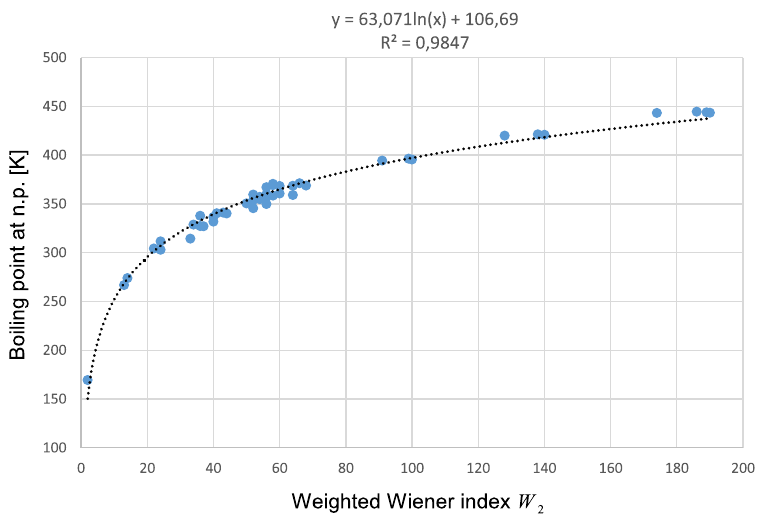
Figure 2. Weighted Wiener indices W 2 and boiling points for the alkenes in the training